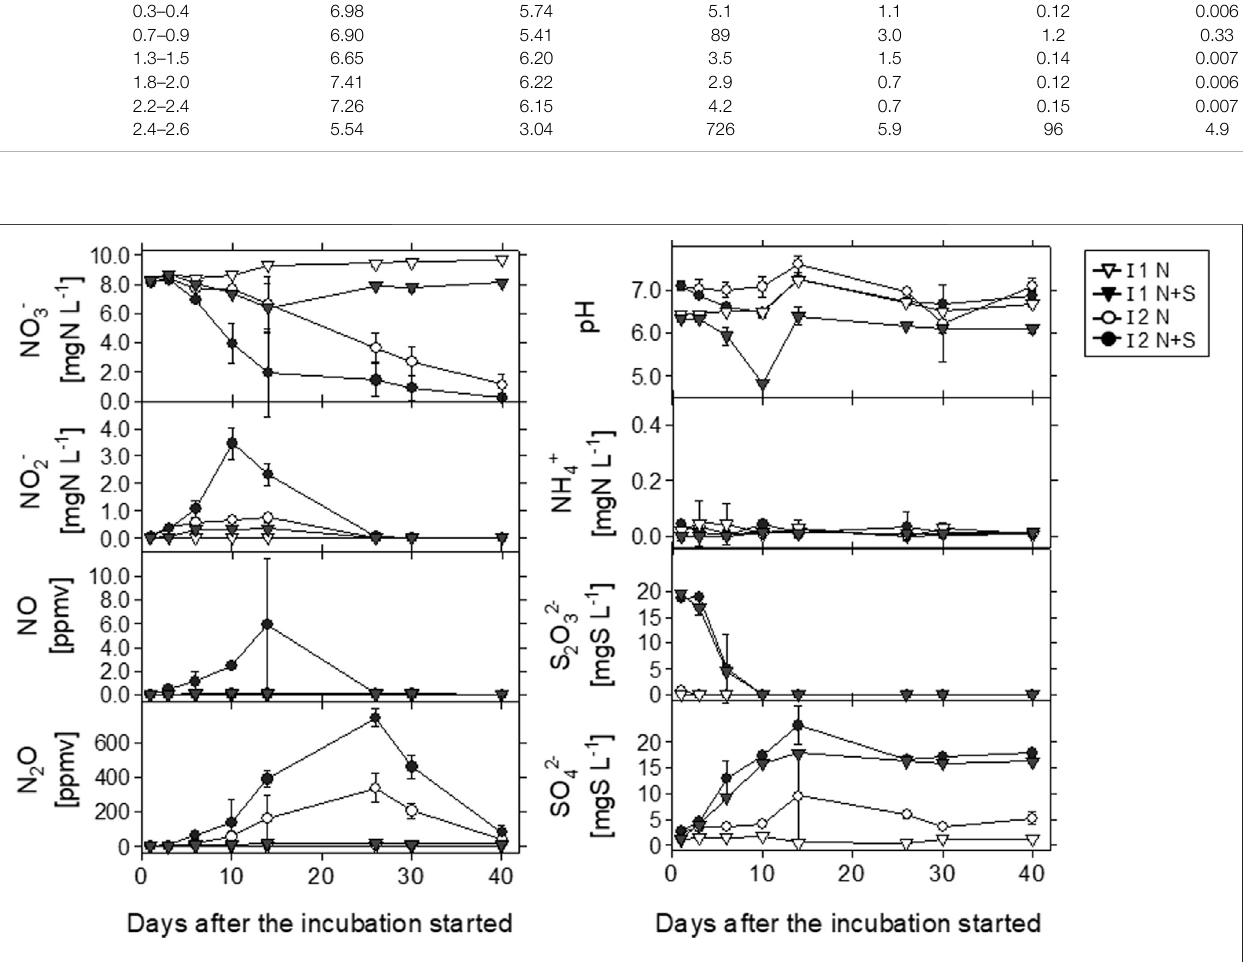
Frontiers in Environmental Science |